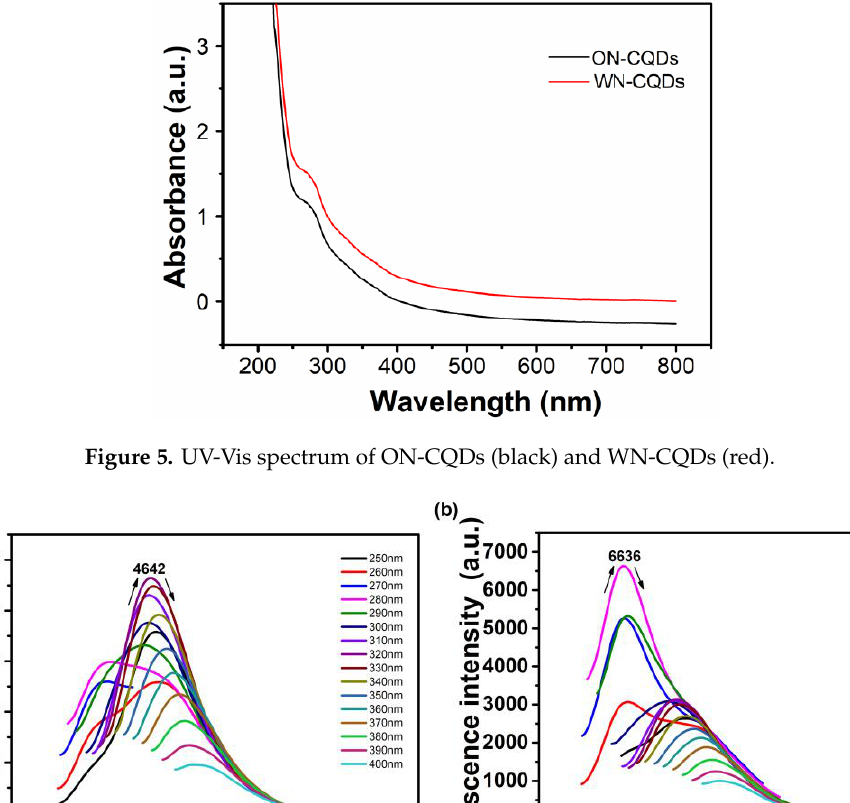
Figure 6. Excitation-dependent fluorescence emission spectra of N-CQDs: ( a ) ON-CQDs; ( b ) WN- CQDs.